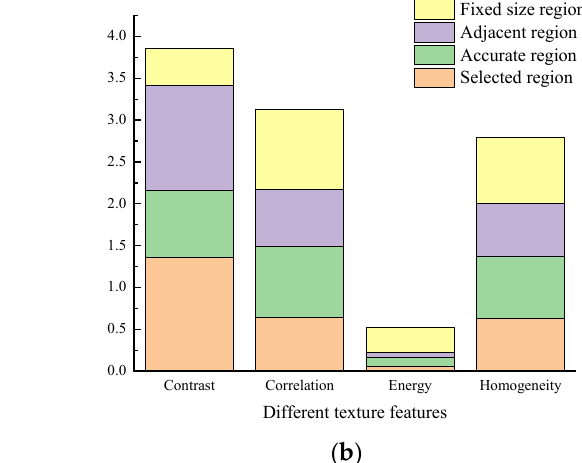
Figure 12. Two evaluation metrics for edge extraction. ( a ) PR metric and ( b ) BR metric.